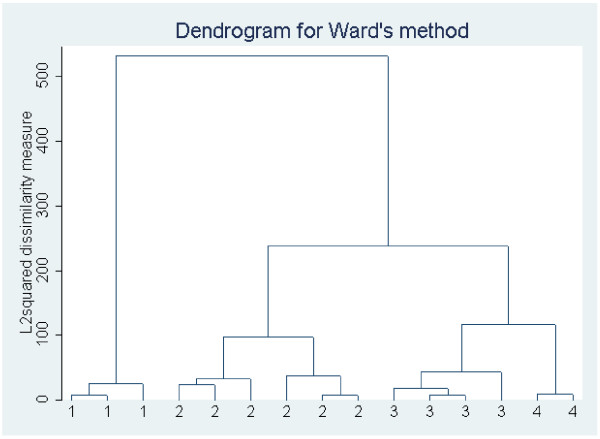
A dendrogram obtained with Ward’s method, describing the formation of clusters.